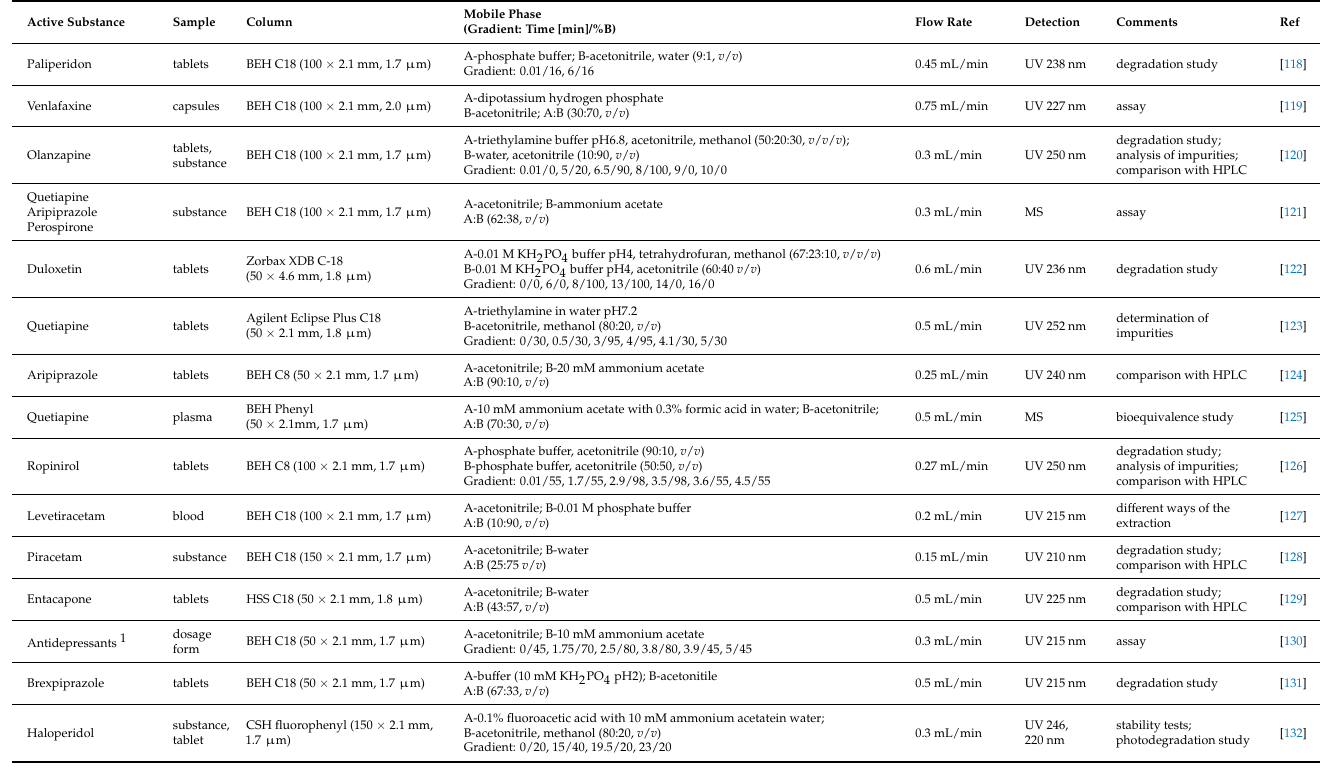
Table 3. UPLC technique in the analysis of antipsychotics, antidepressants, and drugs used in diseases of the nervous